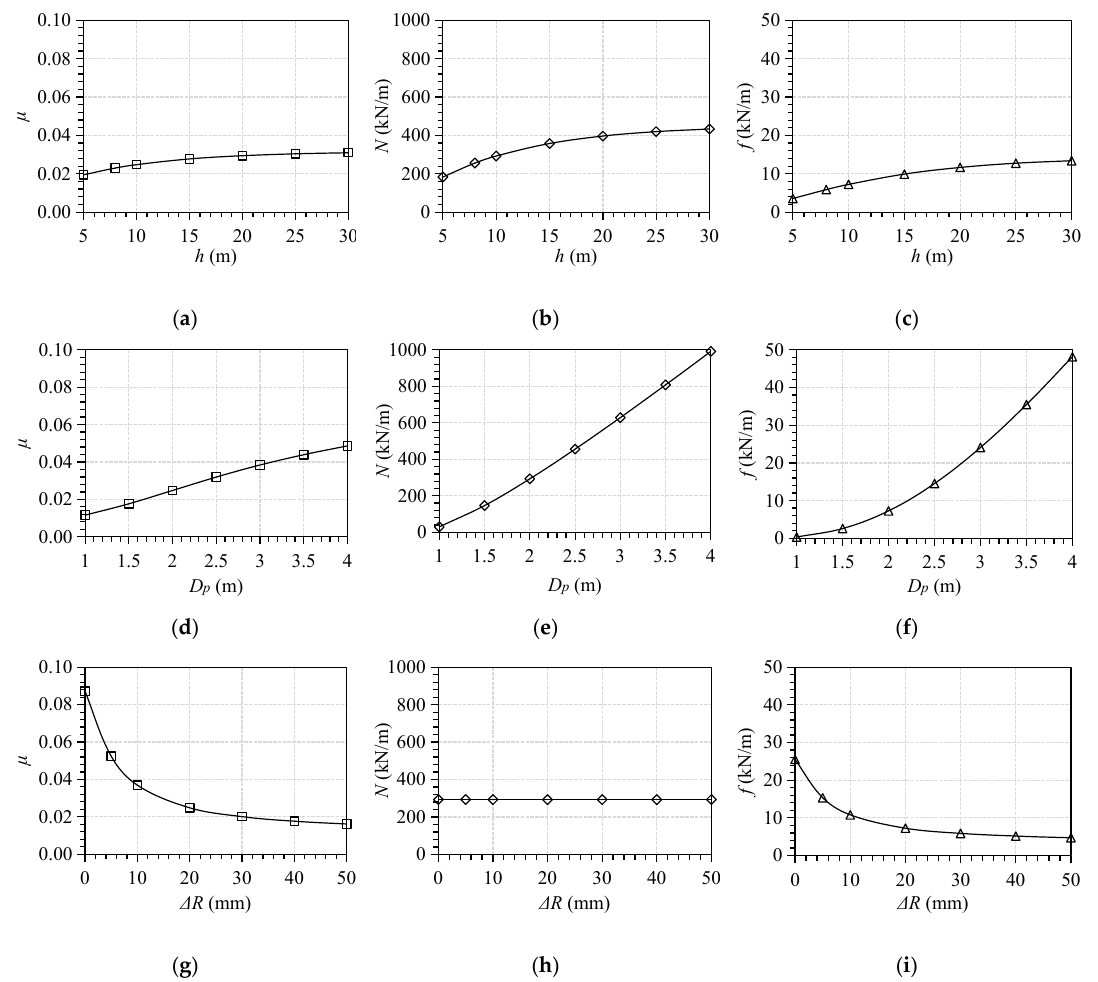
Figure 9. The influence of factors of h , D p , and Δ R on the quantities of μ ( a – c ), N ( d – f ) , and f ( g – i ) .